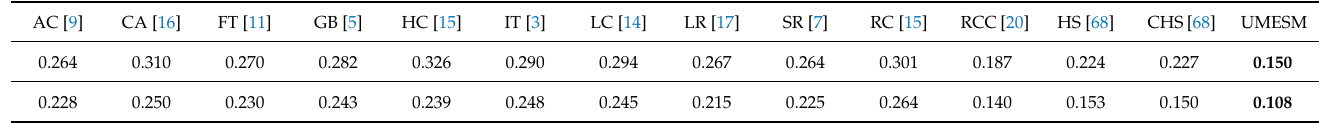
Table 1. Quantitative comparison for MAE on ECSSD [68] (first column) and MSRA-5000 (second column)